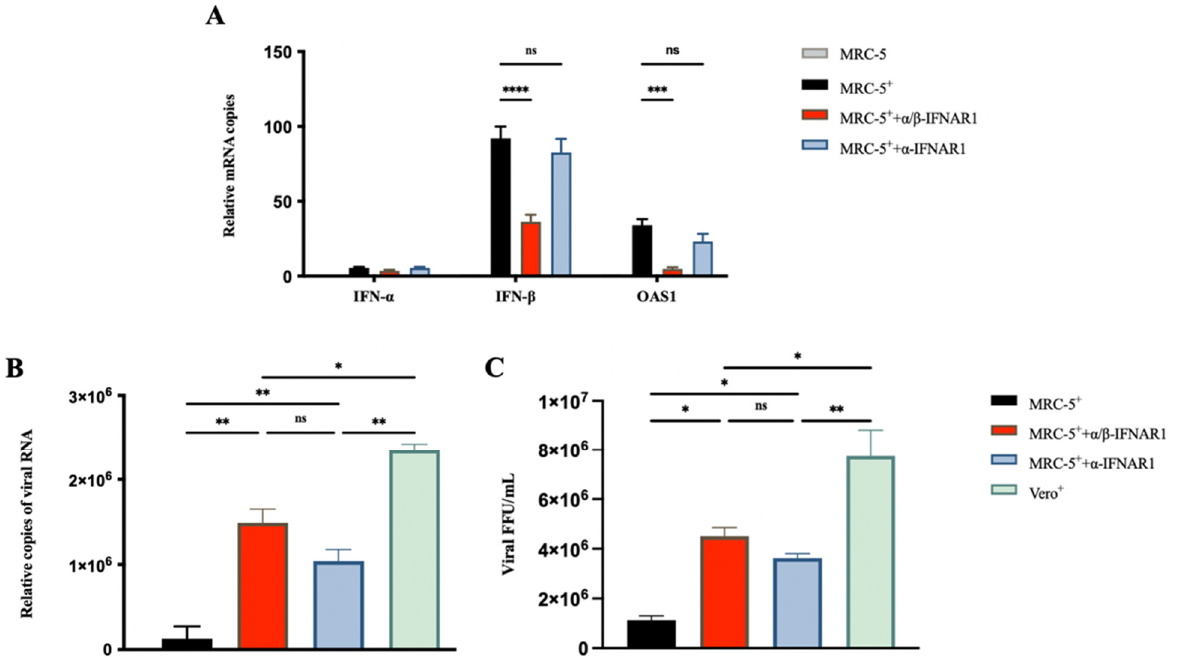
Figure 3. IFNAR1 antibodies enhanced RABV production in MRC-5 cells. MRC-5 cells were infected with the PM RABV strain at an MOI of 0.05. Vero cells were infected with the aG RABV strain at an MOI of 0.001. The IFNAR1 monoclonal antibodies α / β -IFNAR1 and α -IFNAR1 were incubated with MRC-5 cells 2 h before virus infection at a concentration of 1 ng/mL. ( A ) Total RNA from cells was extracted at 24 hpi, and the expression of IFN- α , IFN- β , and OAS1 mRNA was detected by qRT-PCR. Viral RNA ( B ) and titer ( C ) in the culture supernatant were detected by qRT-PCR and FFU assays at 168 hpi. + : RABV infection; * p < 0.05; ** p < 0.01; *** p < 0.001; **** p < 0.0001; ns p ≥ 0.05.